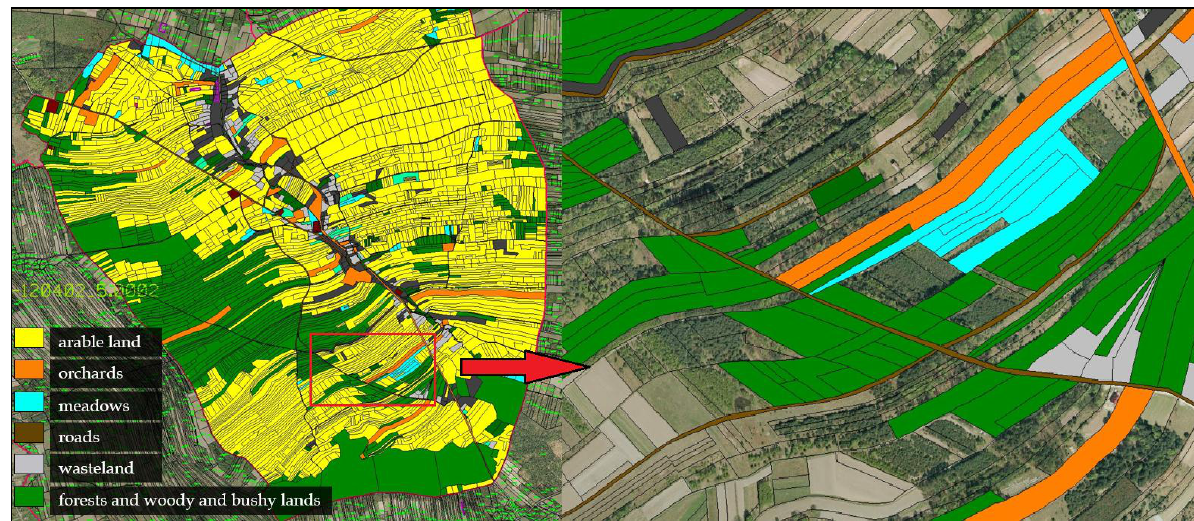
Fig. 2. Land use in the LPR and the actual land use have been marked on the orthophoto map (colours not included in the key do not influence analyses because the key aspect here is the occurrence of arable land in the LPR compared to the actual land use in situ ) (after Janus & Taszakowski,